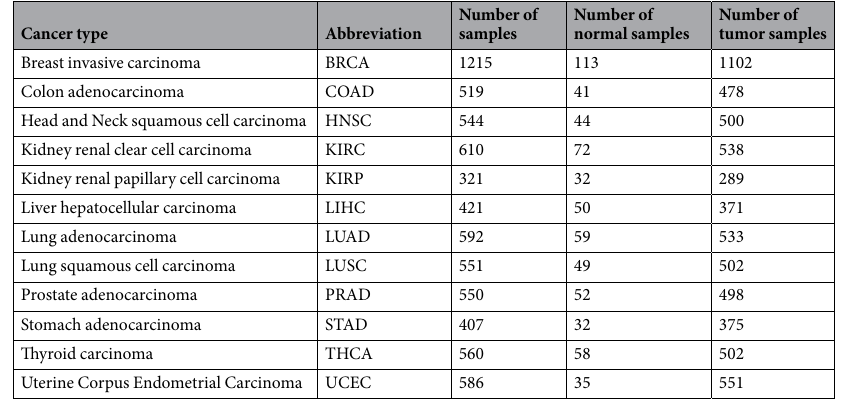
Table 1. List of human cancer types analyzed in the